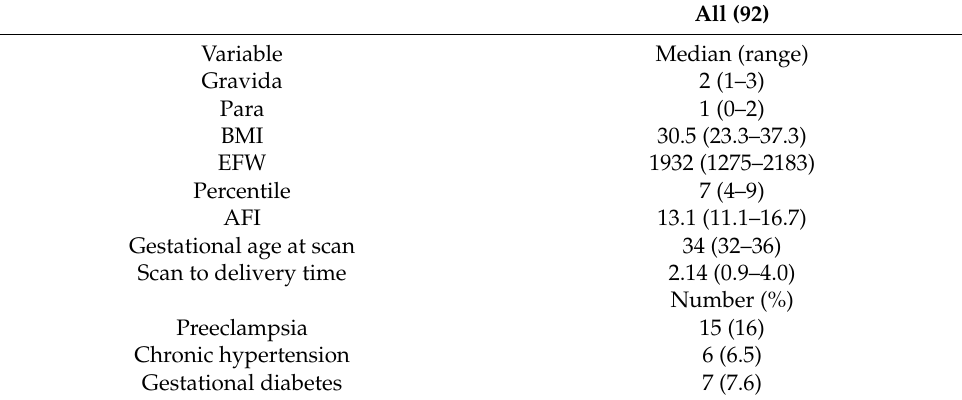
Table 1. Maternal